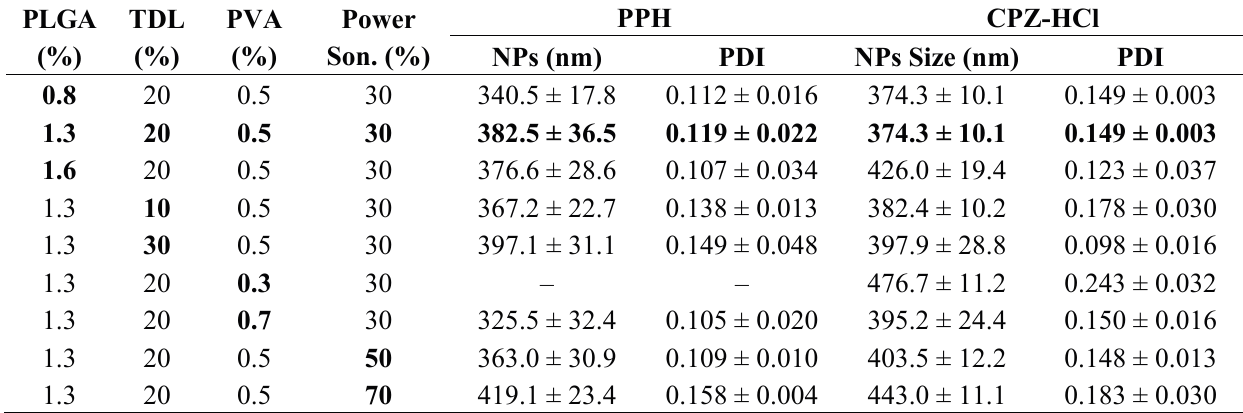
Table 2. Effect of poly( DL -lactide-co-glycolide) (PLGA), the theoretical drug